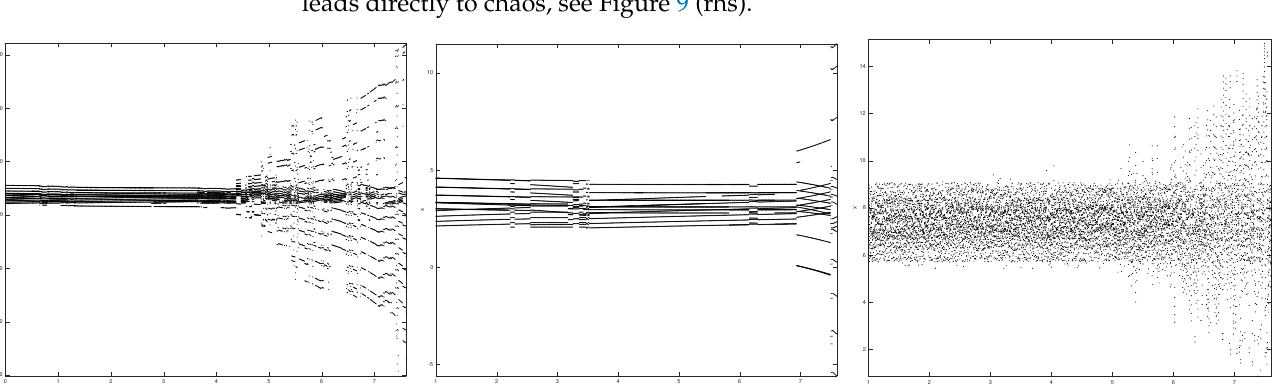
Figure 9. Bifurcation diagrams for the chartist map with respect to the parameter e . ( left ) shows the diagram with a = 0.9, b = 1 and e ∈ [ 0,7.6 ] . ( middle ) shows the diagram with a = 0.9, b = 0.8 and e ∈ [ 0,7.6 ] . ( right ) shows the diagram with a = 1.1, b = 0.8 and e ∈ [ 0,7.6 ] . Note that having the lower the b the later the chaos